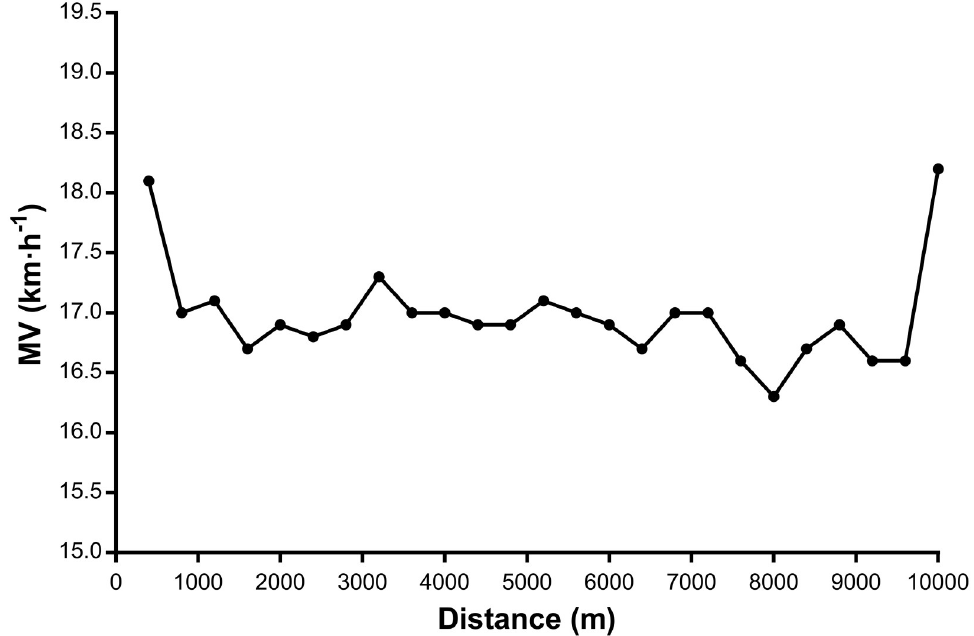
Fig 3. Mean Velocity during the different phases adopted by the participants of the present study for 10-km running performance. Note: MV, Mean